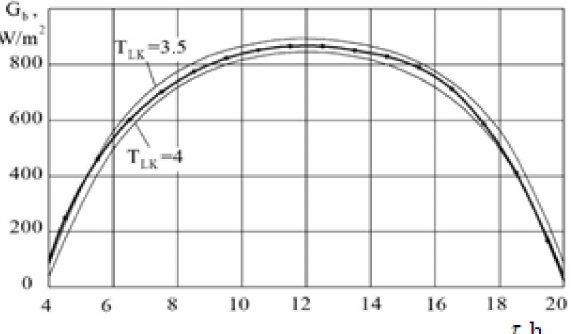
Figure 5. Correlation of the natural flow intensity at the meteorological station “Boryspil” (a heavy line) and that modeled under two values of air turbidity (thin lines)—(own